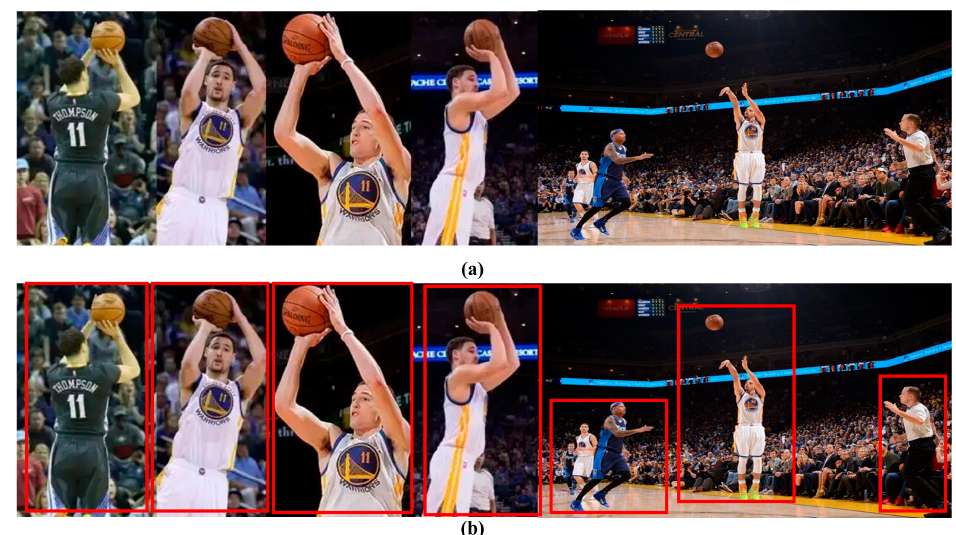
Figure 12. Basketball game video. ( a ) Figure representing the input competition video; ( b ) figure representing the result after recognition.